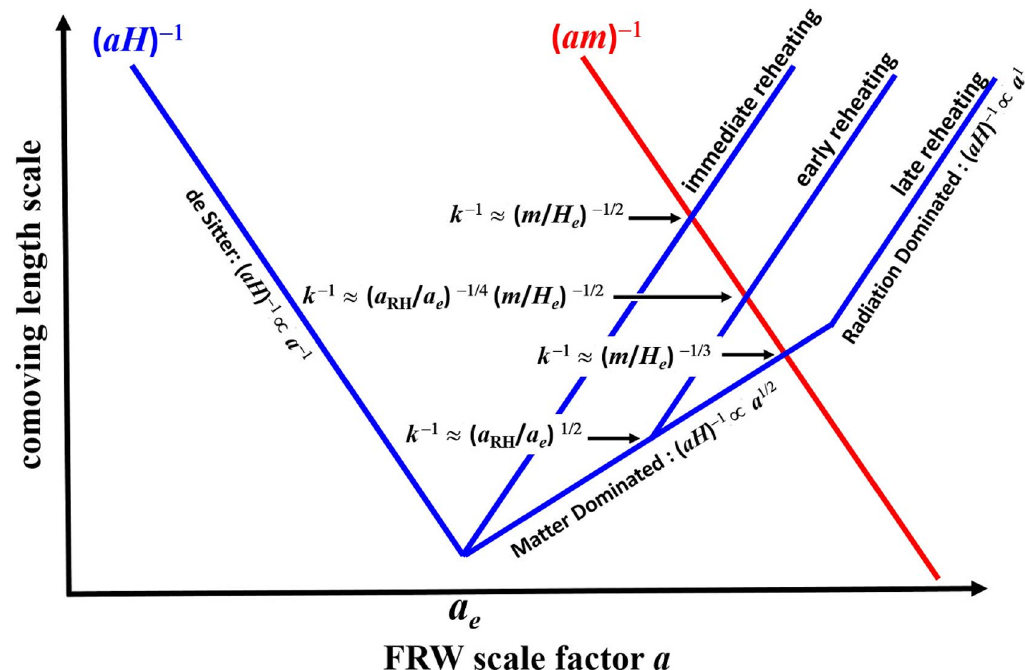
Figure 1 . This diagram illustrates the comoving Hubble scale ( aH ) − 1 and the comoving Compton wavelength ( am ) − 1 of the vector field for the three reheating scenarios discussed in the text, and it highlights the comoving wavenumbers, k = 2 π/λ , that are important for understanding the spectrum of gravitationally-produced spin-1 dark matter. Inflation ends at a = a e when H ( a e ) = H e , and we assume m (cid:28) H e . In the de Sitter phase H ≈ const . , before reheating H ∝ a − 3 / 2 , and after reheating H ∝ a − 2 . We illustrate three possibilities: Late Reheating: If reheating has not completed by the time when m ≈ H ( a ) , then the spectrum is well-approximated by a power law with a single break at k − 1 ≈ ( m/H e ) − 1 / 3 , which corresponds to the special mode that reenters the Hubble radius at the same time when m = H . Early Reheating: If reheating completes before m ≈ H ( a ) then the spectrum is a power law with two breaks. Immediate Reheating: In the limit where the duration of reheating goes to zero, the early reheating scenario is approximated by the